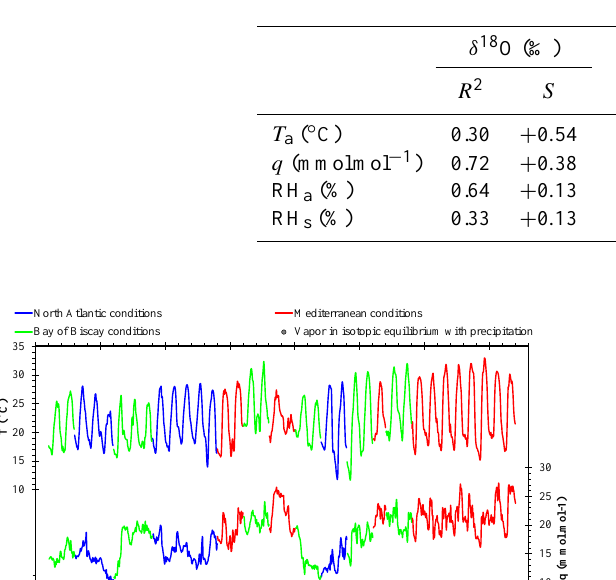
Table 4. Determination coefficients ( R 2 ) and slopes ( S ) of linear correlations between daily means of water vapour composition ( δ 18 O, δ D, d ) and air temperature ( T a ), mixing ratio ( q ), relative humidity at air temperature (RH a ) and relative humidity at water surface temperature (RH s ).